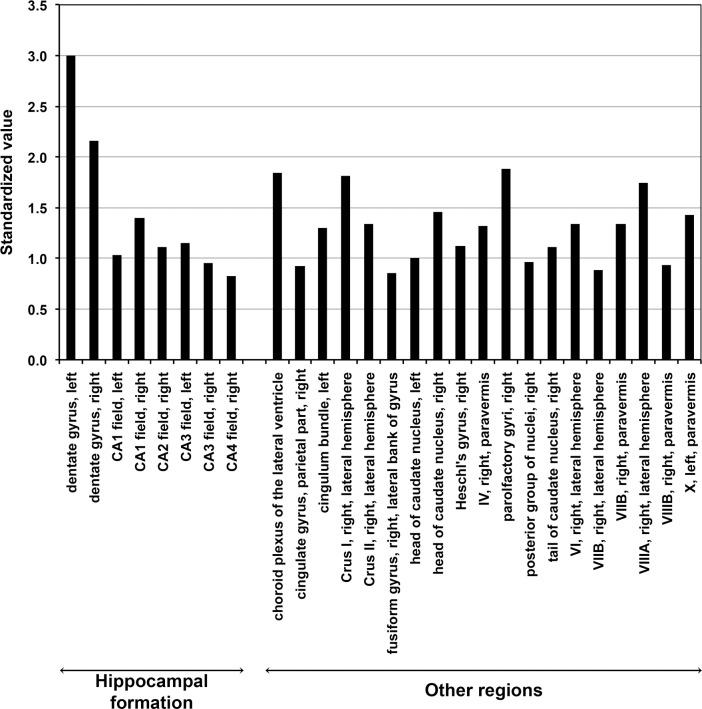
Expression of BAHD1 in the human brain.Integrative analyze by Harmonizome database (https://amp.pharm.mssm.edu/Harmonizome/gene/BAHD1) of BAHD1 mRNA expression profiles for six adult human brain tissue samples from the Allen Human Brain Atlas (http://human.brain-map.org)[23]. The 27 tissues with the highest expression of BAHD1 relative to all brain tissues (about 300 brain structures) are shown. Standardized values are indicative of the relative strength of the functional associations and are related to empirical p-values, as “abs(standardized values) = -log10(p-value)”.